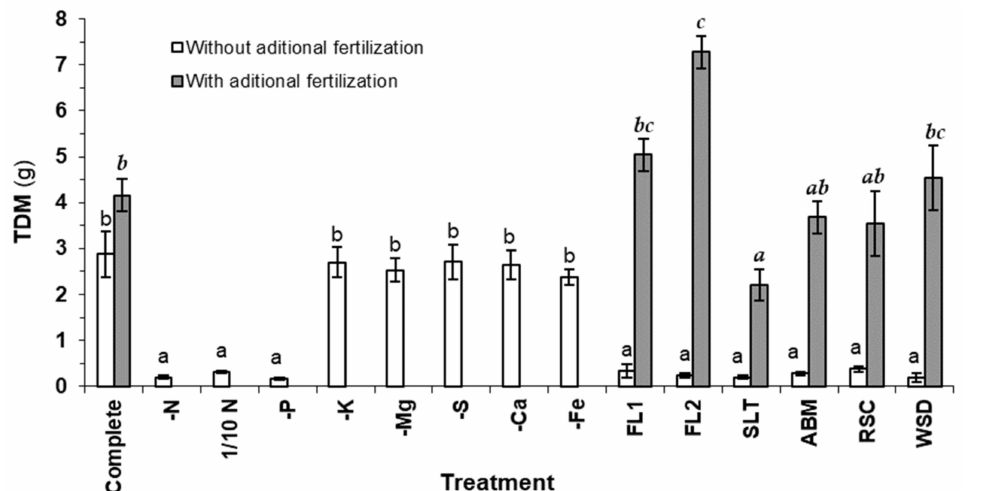
Figure 6. Total dry biomass (TDM) per treatment at the end of the mineral nutrition and substrate trials (mean ± SE), both without and with additional fertilization. Different letters on each bar indicate significant differences between treatments within each trial ( p <